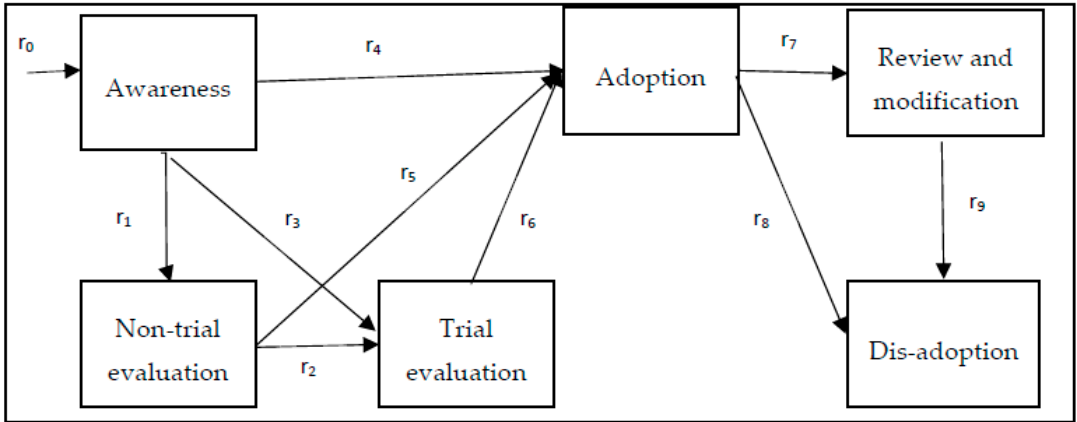
Figure 2. Step-hazard representation of the adoption process proposed by Pannell et al. [30].